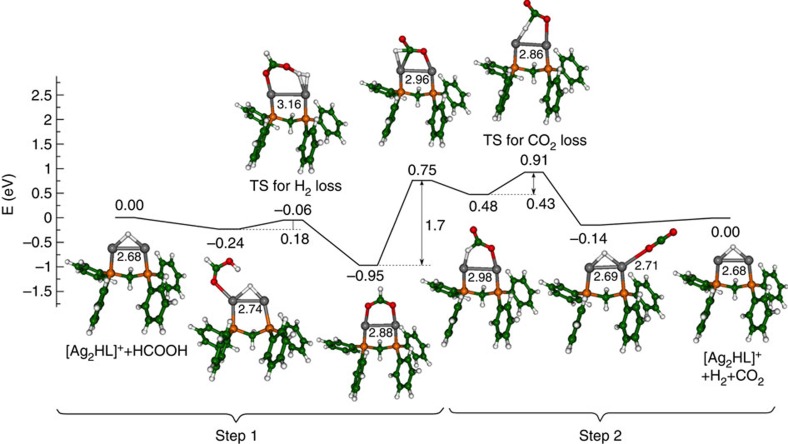
DFT-calculated energy profile for the two reaction steps in the catalytic cycle of Fig. 1a.(Step 1) ion-molecule reaction of formic acid with [dppmAg2(H)]+; (step 2) CID decarboxylation of [dppmAg2(O2CH)]+. Relative energies are in eV.